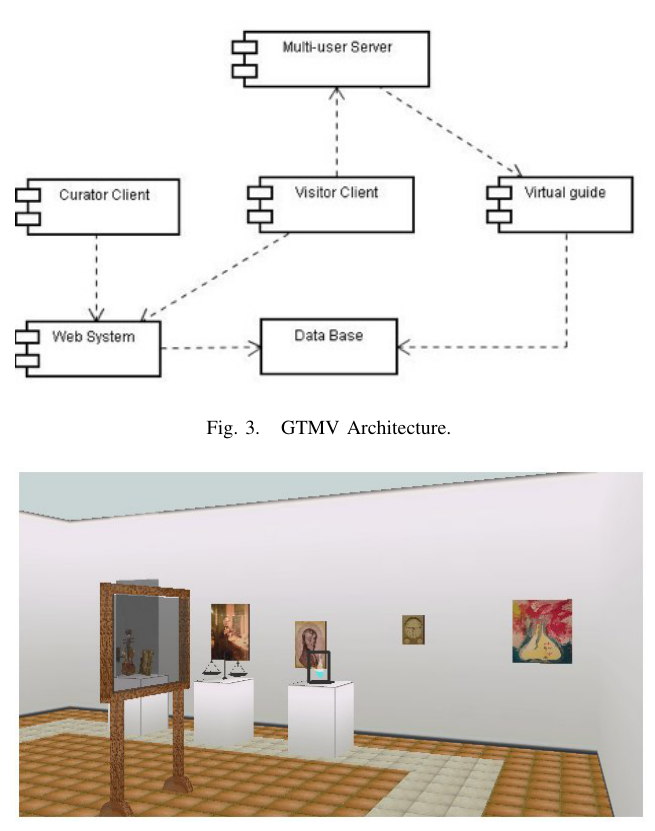
Fig. 4. First museum modeled by our GTMV system: Museum of the Nucleus of Art and Culture (NAC) at UFRN.